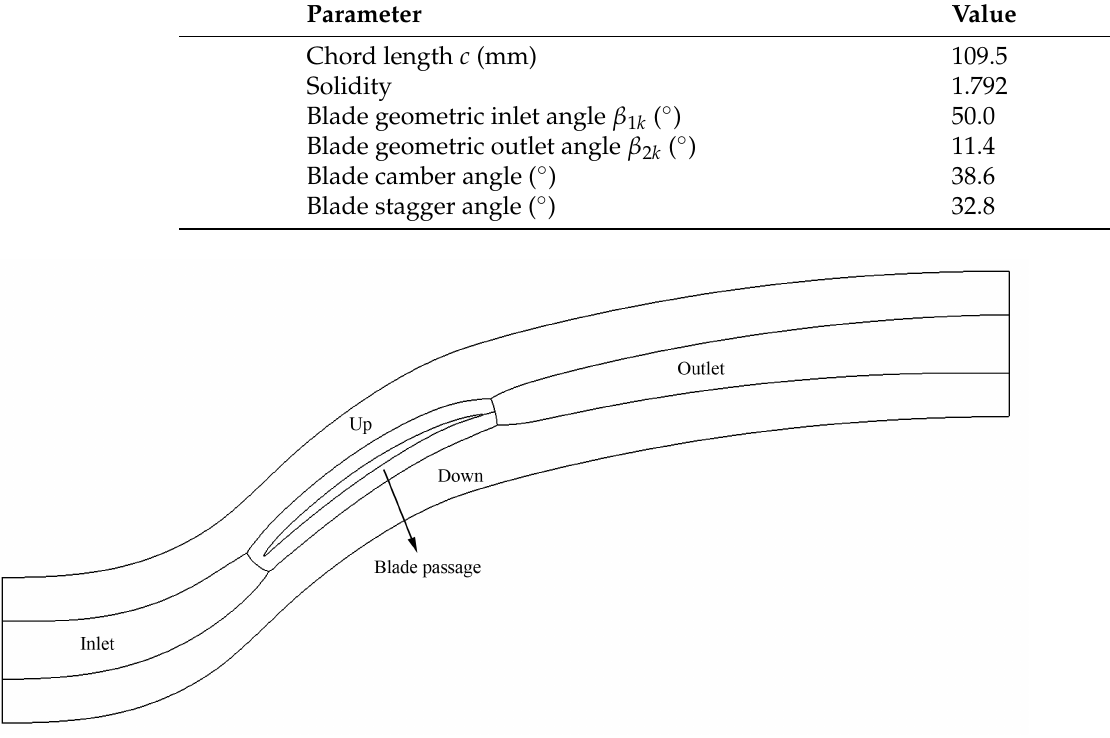
Figure 8. An illustration of blade-to-blade topology.